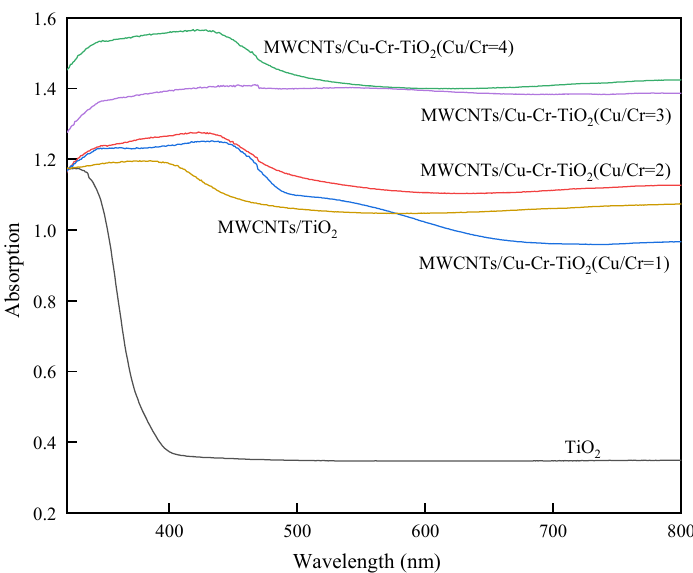
Figure 5. Diffuse reflectance spectra (DRS) of TiO 2 , MWCNTs/TiO 2 and MWCNTs/Cu-Cr-TiO 2 (Cu/Cr = 1, 2, 3, 4).